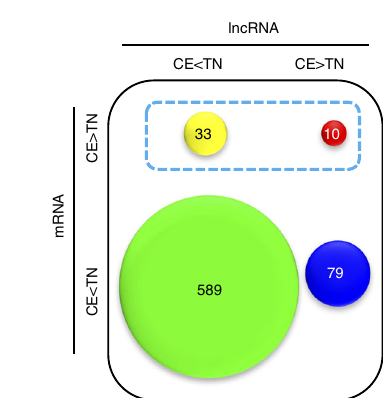
Fig. 4 Comparison of global expression changes upon cold exposure (relative to thermoneutral conditions) in human BAT and WAT tissues. a Distribution of gene expression changes upon cold exposure for lncRNA (left panel) and mRNA (right panel). b Top 10 enriched gene ontology processes of the upregulated mRNAs in BAT upon cold exposure. c 2 by 2 matrix depicting the gene expression changes in adult BAT upon cold exposure for lncRNA – mRNA pairs. Size of each circle is proportional to the number of lncRNA – mRNA pairs. CE cold exposure, TN